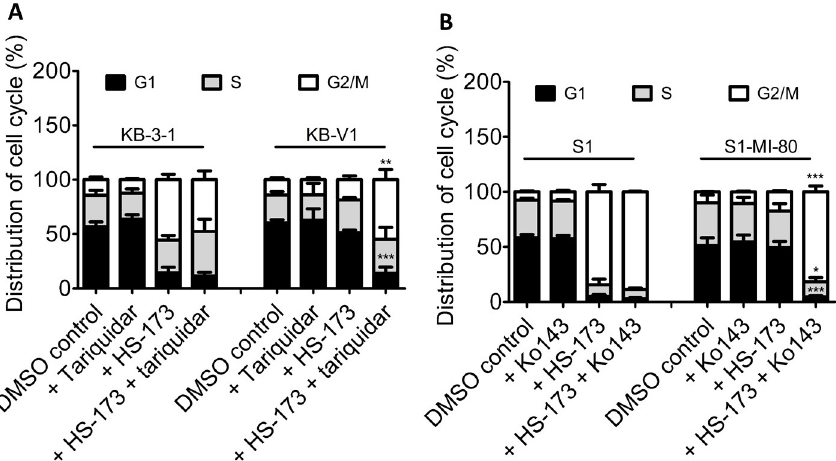
Figure 2. Differential effect of HS-173 on G2/M cell cycle arrest in drug-sensitive and multidrug- resistant cancer cells overexpressing ABCB1 or ABCG2. ( A ) KB-3-1 and KB-V1 cells were treated with DMSO (control), 1 µM tariquidar, 2 µM HS-173, or a combination of HS-173 and tariquidar; ( B ) S1 and S1-MI-80 cells were treated with DMSO (control), 1 µM Ko143, 2 µM HS-173, or a combination of HS-173 and Ko143 for 24 h before harvesting for cell cycle analysis, as described in the Materials and Methods section. * p < 0.0 5 ; ** p < 0.01; *** p < 0.001.